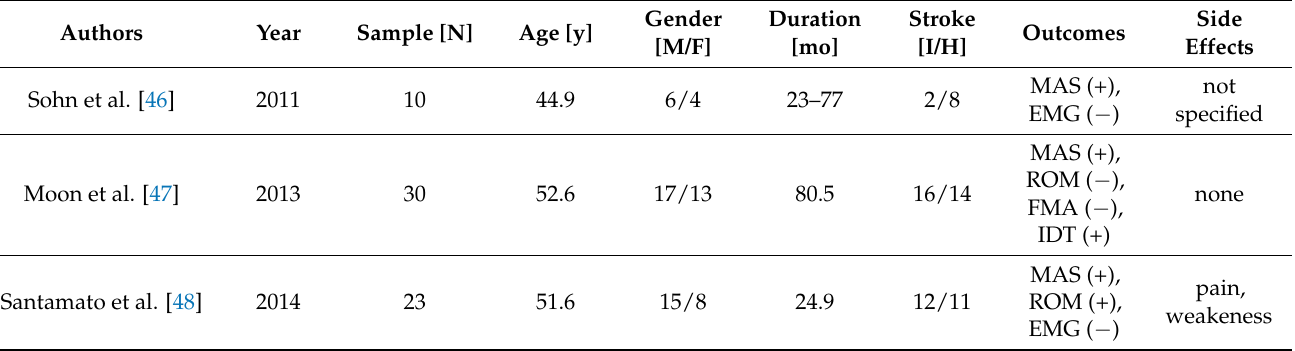
Table 4. Lower limb—characteristics of patients and